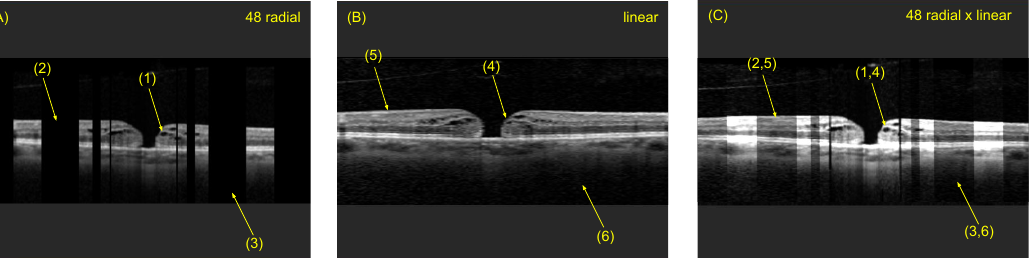
Figure 10. Visualized example of the information gain by radial and linear reconstruction. Image ( A ) shows a B-scan slice taken from the 48 radial B-scan slice reconstruction and Image ( B ) shows the same cross-sectional B-scan slice from the linear reconstruction. Image ( C ) shows the resulting fused OCT after selective masking of the linear OCT ( B ), compounding it with Image ( A ). At location (2,5), (3,6) and (1,4), the information gain is clearly visible (different intensities represent different